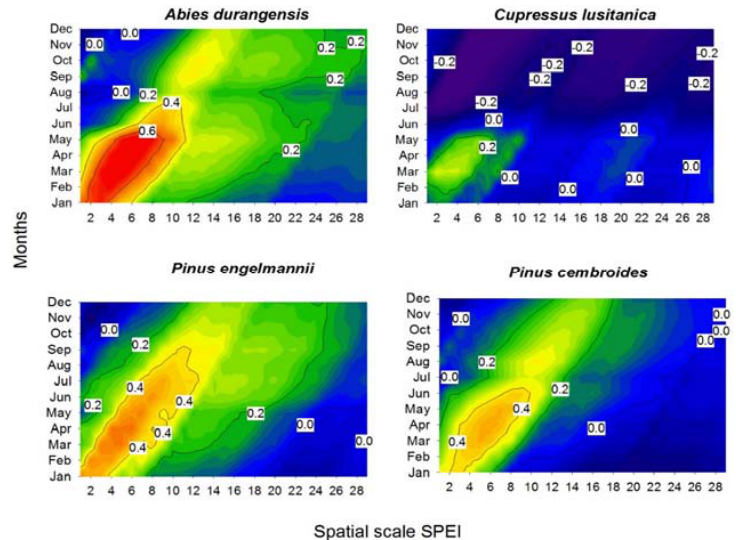
Figure 4. Correlations between the standardized precipitation evapotranspiration index (SPEI) drought index and residual ring ‐ width chronologies for the four study conifer species. The SPEI was calculated on a scale of 1–28 months ( x ‐ axis) from January–December ( y ‐ axis) of the growth year. The graphs show the Pearson correlation coefficients ( r ) using color scales. Values of r above 0.2 are significant ( p < 0.05).